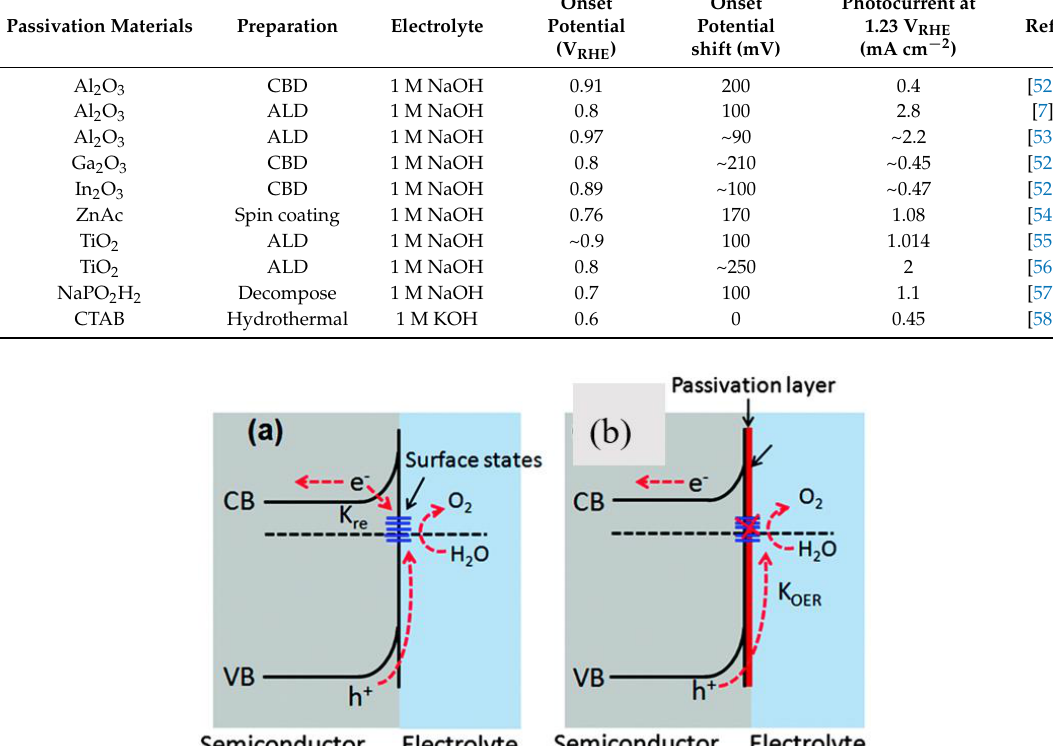
Table 3. List of materials and preparation methods used for surface passivation on hematite nanostructures. Passivation Materials